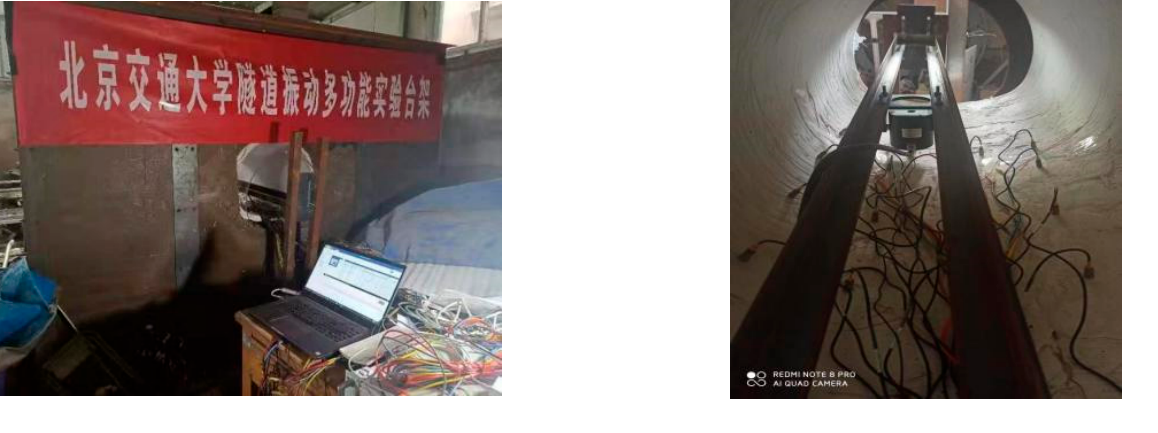
Figure 6. Model test bench.